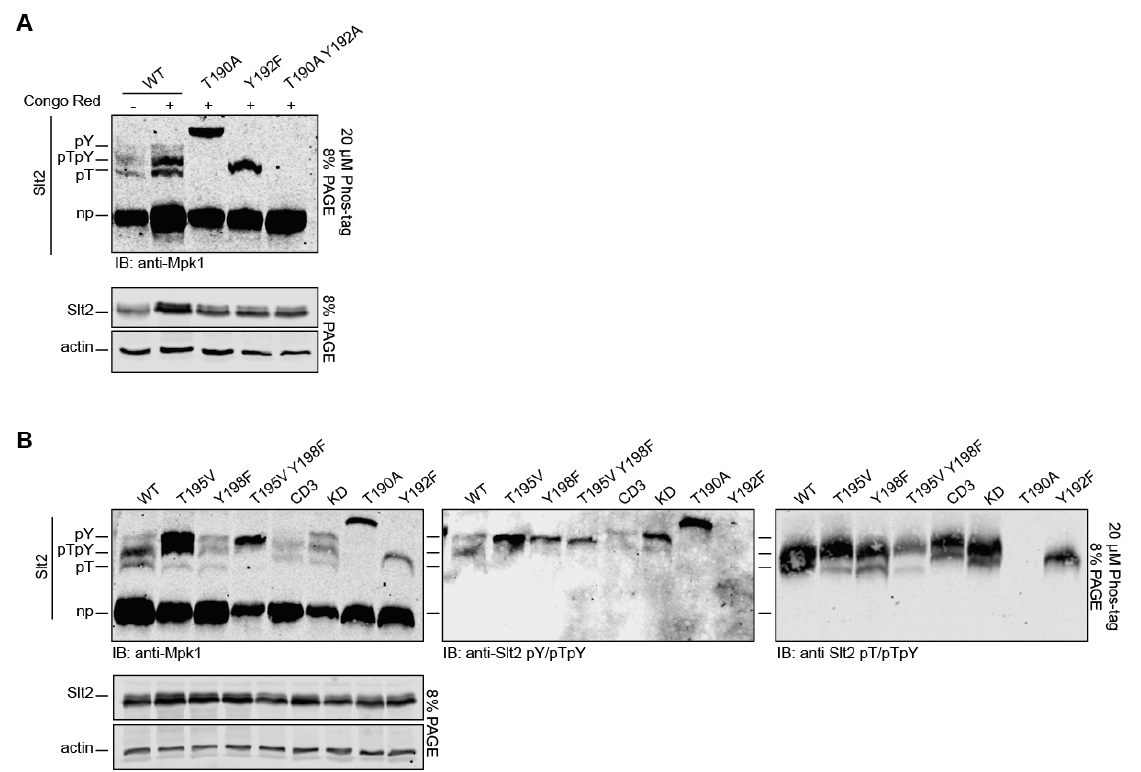
Figure 7. Detection by phosphate-affinity (Phos-tag) of the differentially phosphorylated forms of Slt2. ( A ) BY4741 slt2 ∆ - RLM1Myc cells containing the same plasmid pRS316 expressing Slt2 (WT), Slt2 T190A , Slt2 Y192F , or Slt2 T190A Y192A were grown to the mid-exponential phase in YPD and then stimulated with 30 µ g/mL of CR for 2 h. Cell extracts were resolved by Phos-tag SDS–PAGE (top panel) and SDS–PAGE (bottom panel), and immunoblotted with anti-Mpk1 (Slt2) and anti-actin antibodies. ( B ) Cell extracts of slt2 ∆ -RLM1Myc cells containing plasmid pRS316 expressing the same proteins as in ( A ), as well as Slt2 T195V , Slt2 Y198F , Slt2 T195V Y198F , Slt2 CD3 , and Slt2 KD , resolved as in ( A ) and immunoblotted with anti-Mpk1 (Slt2) and anti-actin (left panels), anti-Slt2-pY/pTpY (middle panel), and anti-Slt2-pT/pTpY (right panel) antibodies. A representative assay from three different experiments with distinct transformants is